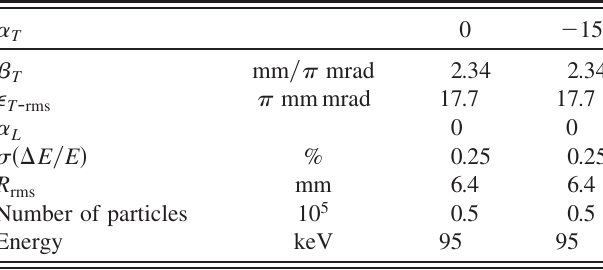
TABLE XV. Beam parameters at solenoid study.